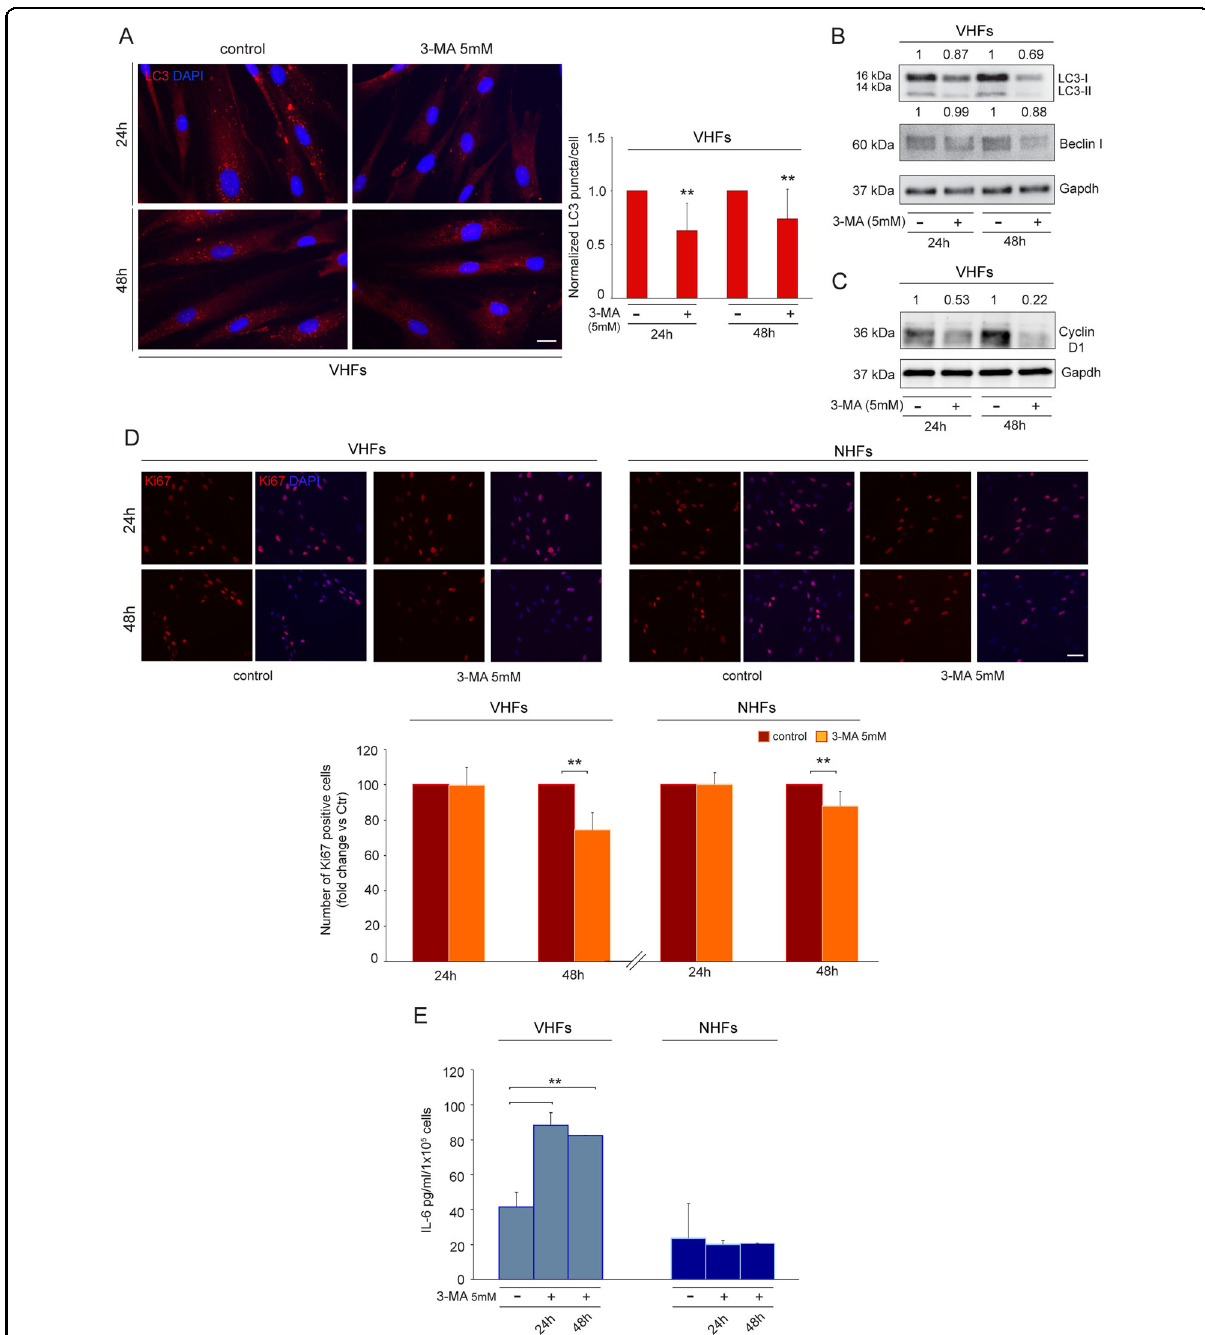
Fig. 6 Suppression of autophagy further impairs Vitiligo fi broblasts. A Immuno fl uorescence analysis and corresponding quantitative analysis of the number of positive LC3 puncta on vitiligo fi broblasts untreated or treated with 3MA (5 mM) for 24 and 48 h ( n = at least 150 cells per group). Nuclei were counterstained with DAPI. Scale bar: 20 μ m. A representative vitiligo fi broblast culture treated with 3-MA is shown; B , C Western blot of LC3-II/I, Beclin I, and Cyclin D1 and corresponding densitometric analysis on vitiligo lysates normalized on control ones after treatment with 3-MA (5 mM) for 24 and 48 h. Representative blots of three independent experiments are shown. D Immuno fl uorescence staining of Ki67 (red) and corresponding percentage of Ki67 positive vitiligo and normal fi broblasts treated or not with 3-MA (5 mM) for 24 and 48 h ( n = at least 700 cells per group). Nuclei were counterstained with DAPI. Scale bar: 50 μ m; E IL-6 quanti fi cation by ELISA in vitiligo and normal fi broblasts untreated and treated with 3-MA (5 mM) for 24 and 48 h (VHFs n = 3 and NHFs n = 3). IL-6 , interleukin 6; LC3-I/II, (microtubule-associated protein 1) light chain 3; 3-MA, 3- methyl adenine; qRT-PCR, quantitative real-time reverse transcriptase-PCR; VHFs, vitiligo human fi